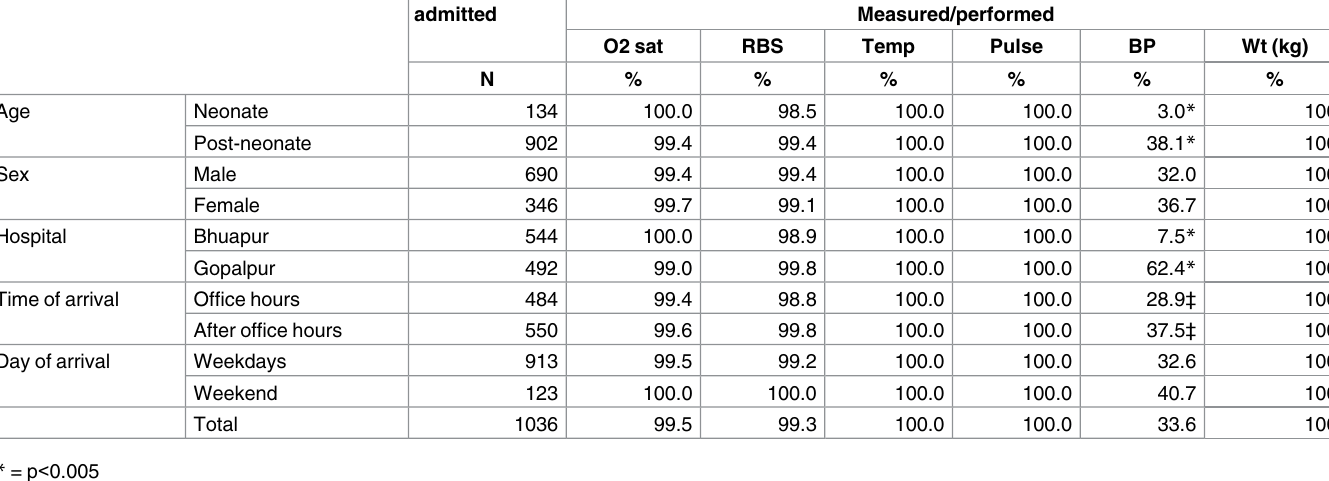
Table 1. Status of Fast Assessment of syndromic sepsis patients in the inpatient department.